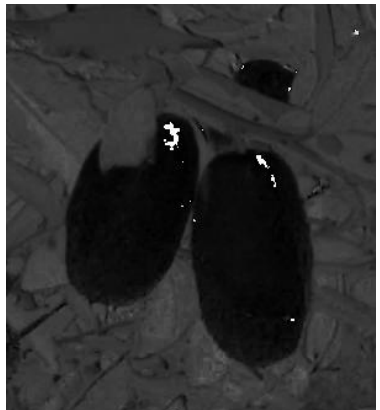
Figure 9. Extracted hue information.